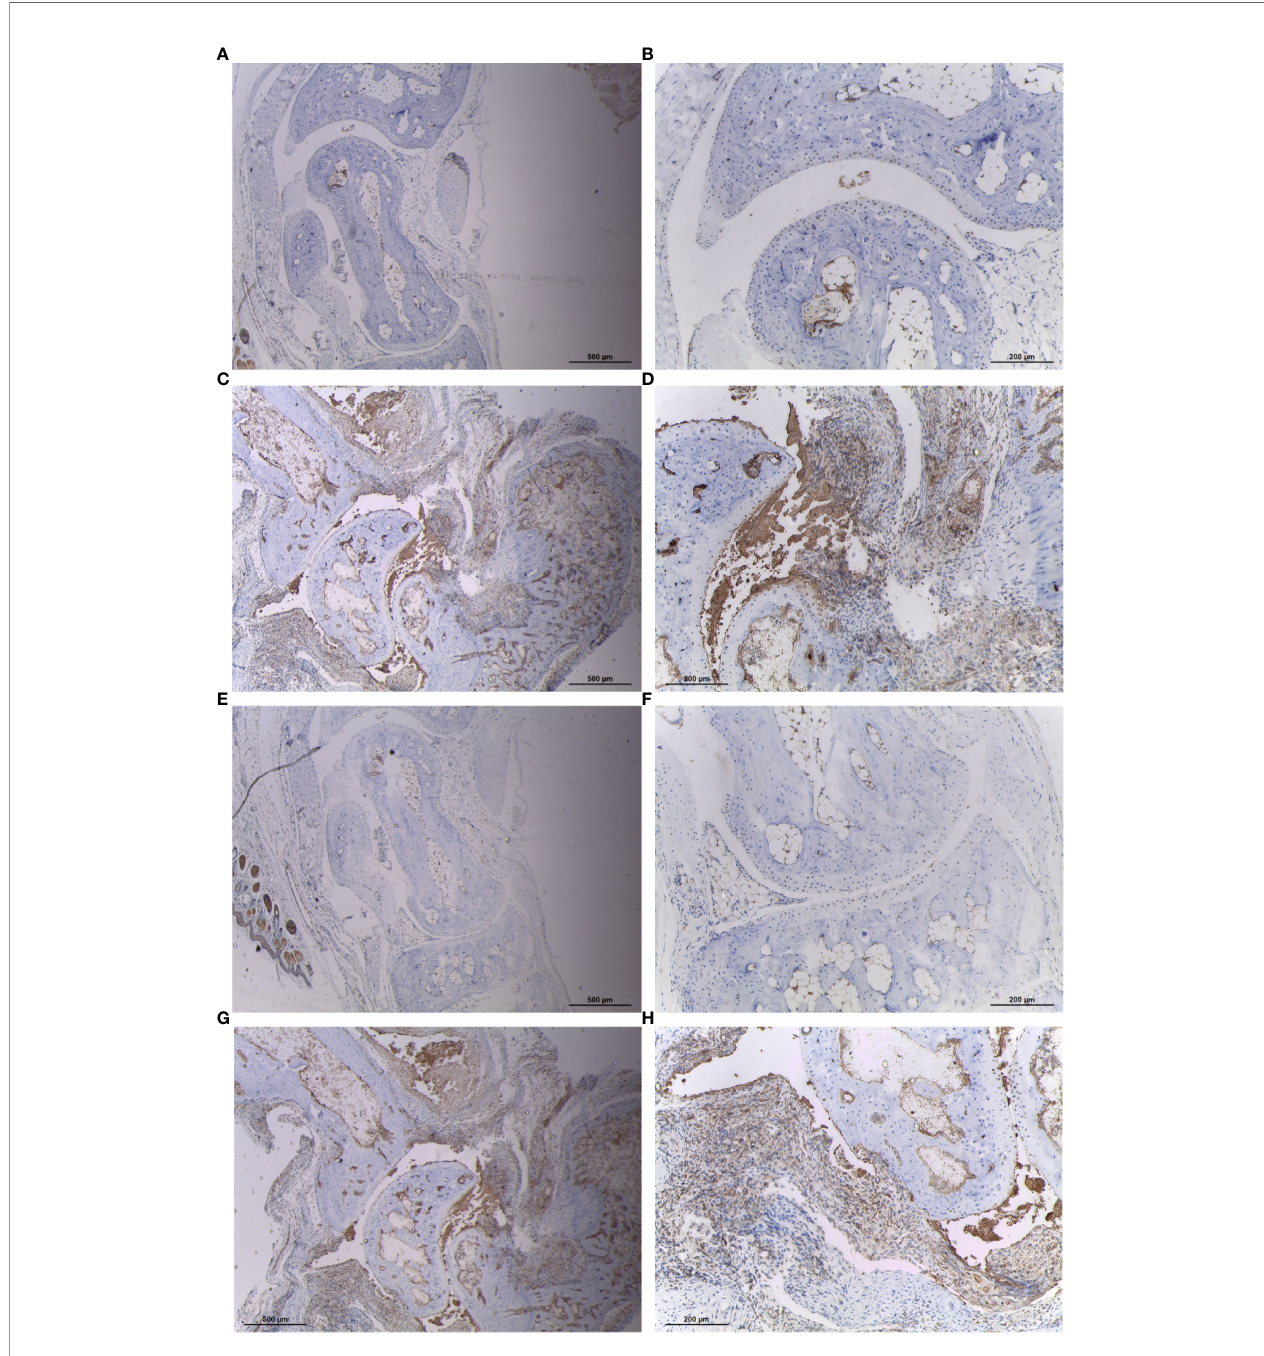
FIGURE 9 | Expression of CYFIP2 and ST8SIA1 in the synovial membrane of CIA mice. (A, B) Immunohistochemical analysis of CYFIP2 expression in normal mouse synovium, (( A ) original magni fi cation ×40, (B) original magni fi cation ×100). (C, D) Immunohistochemical analysis of CYFIP2 expression in the synovial membrane of CIA mice, (( C ) original magni fi cation ×40, (D) original magni fi cation ×100). (E, F) Immunohistochemical analysis of ST8SIA1 expression in normal mouse synovium, (( E ) original magni fi cation ×40, (F) original magni fi cation ×100). (G, H) Immunohistochemical analysis of ST8SIA1 expression in the synovial membrane of CIA mice, ( G ) original magni fi cation ×40, (H) original magni fi cation